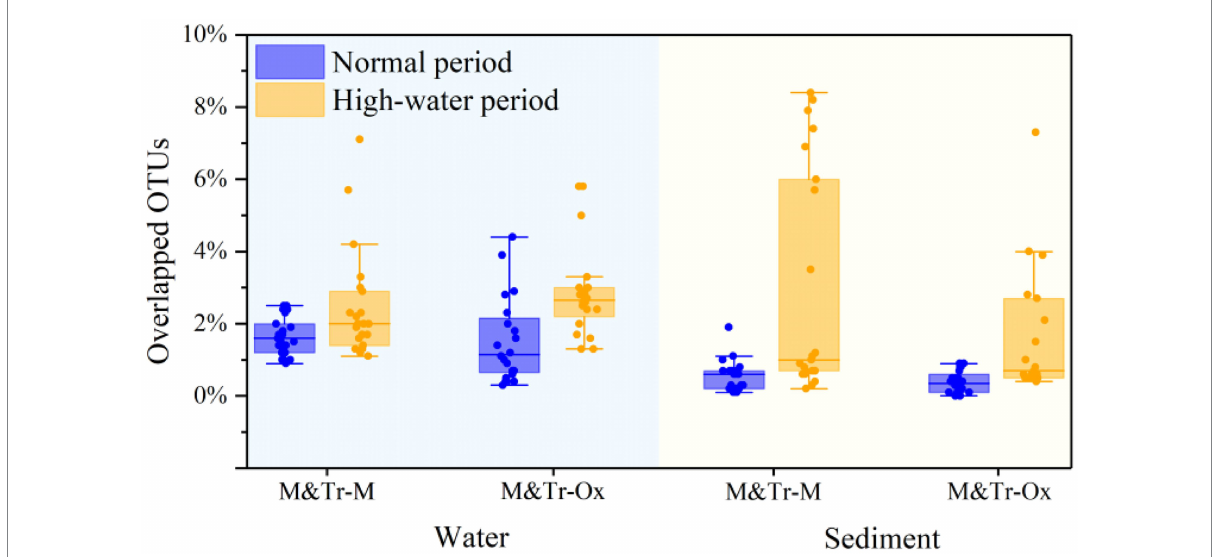
FIGURE 4 Proportions of overlapping operational taxonomic units (OTUs) between adjacent sampling sites in all OTUs of both sites in different study periods. The proportions of overlapping OTUs were used to quantify community coalescence between upstream and downstream sites. M&Tr-M represents the contribution of the upstream mainstream and tributaries to the downstream mainstream, and M&Tr-Ox represents the contribution of the upstream mainstream and tributaries to the downstream oxbow lakes. Data are means ± standard